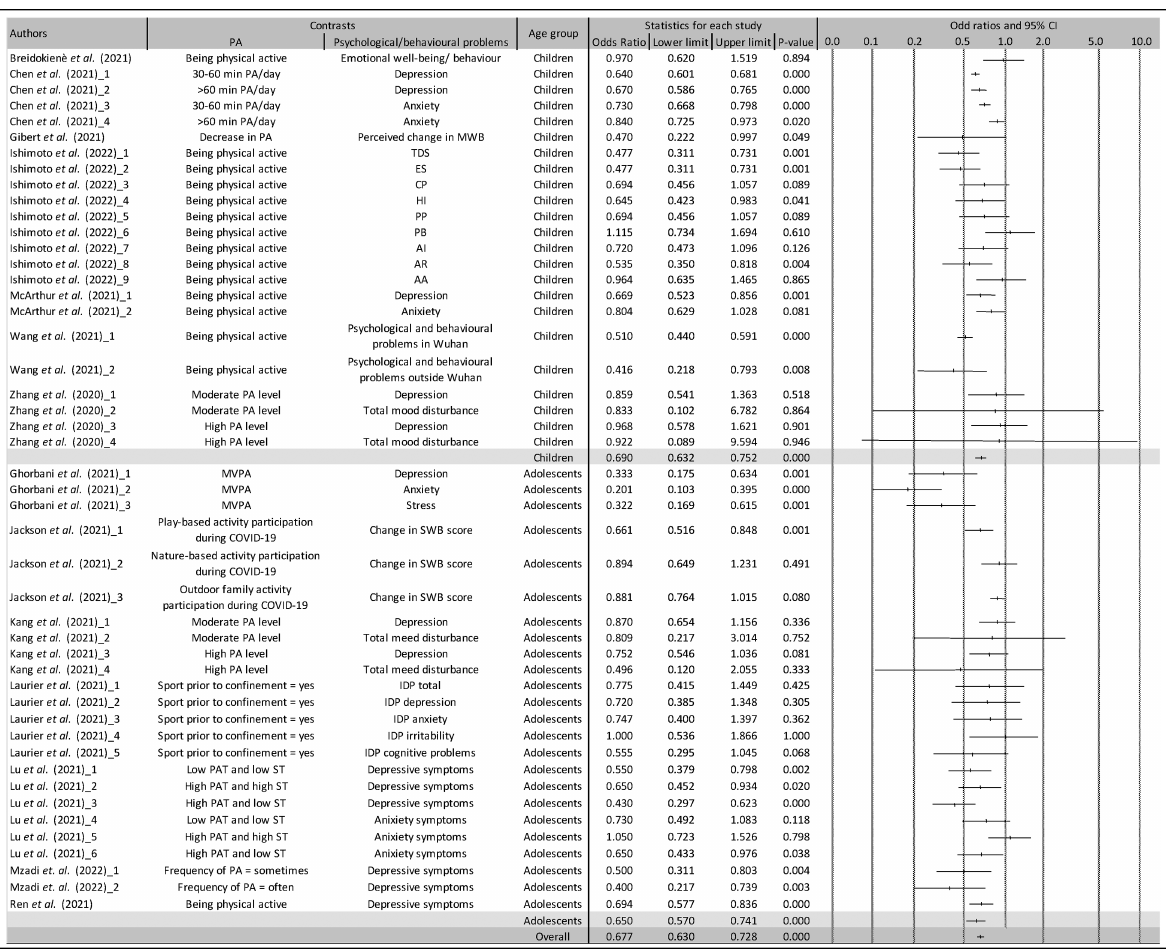
TABLE 2 The relationship between PA and psychological and/or behavior